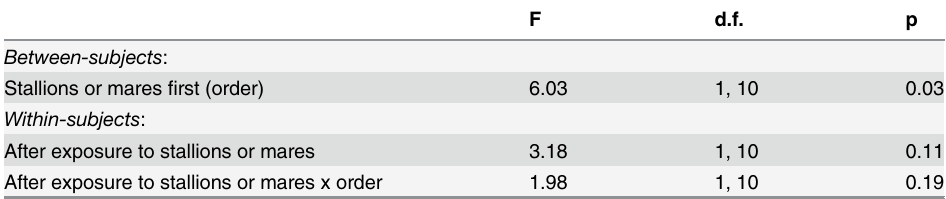
Table 3. MANOVA on average peripheral blood testosterone levels during exposure to stallions or to mares.